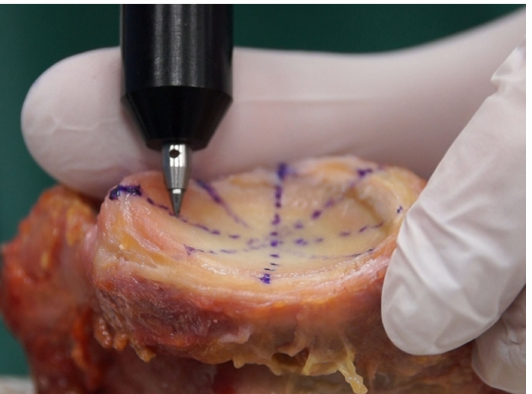
Figure 1. Sampling of the osteochondral glenoid shape with a 3D measuring arm. More than 100 surface points were digitized. In addition, anatomical landmarks were acquired for alignment of the superoinferior and anteroposterior axes on the long and short axes of the glenoid, respectively.